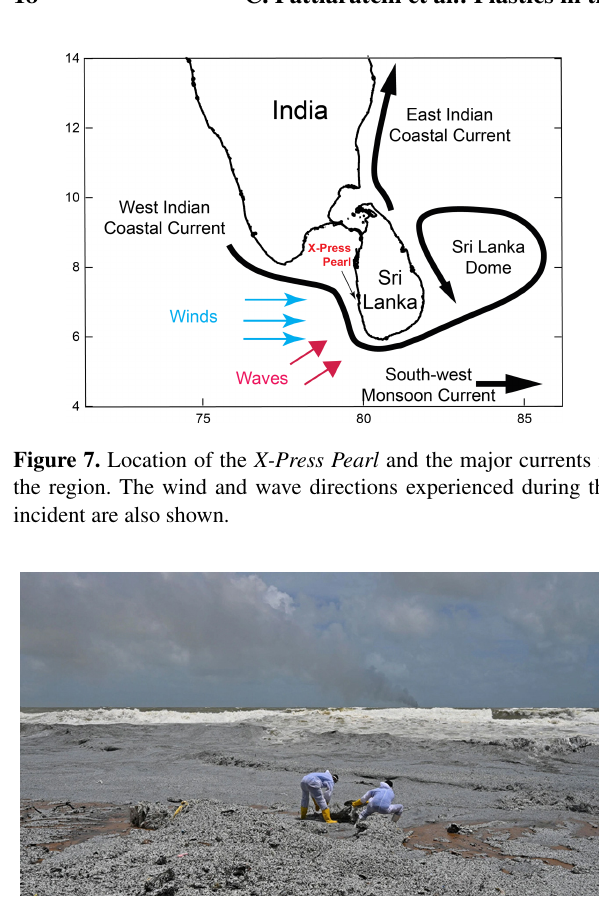
Figure 8. Image of nurdles on the beach directly to the east of the spill from the X-Press Pearl (location in Fig.